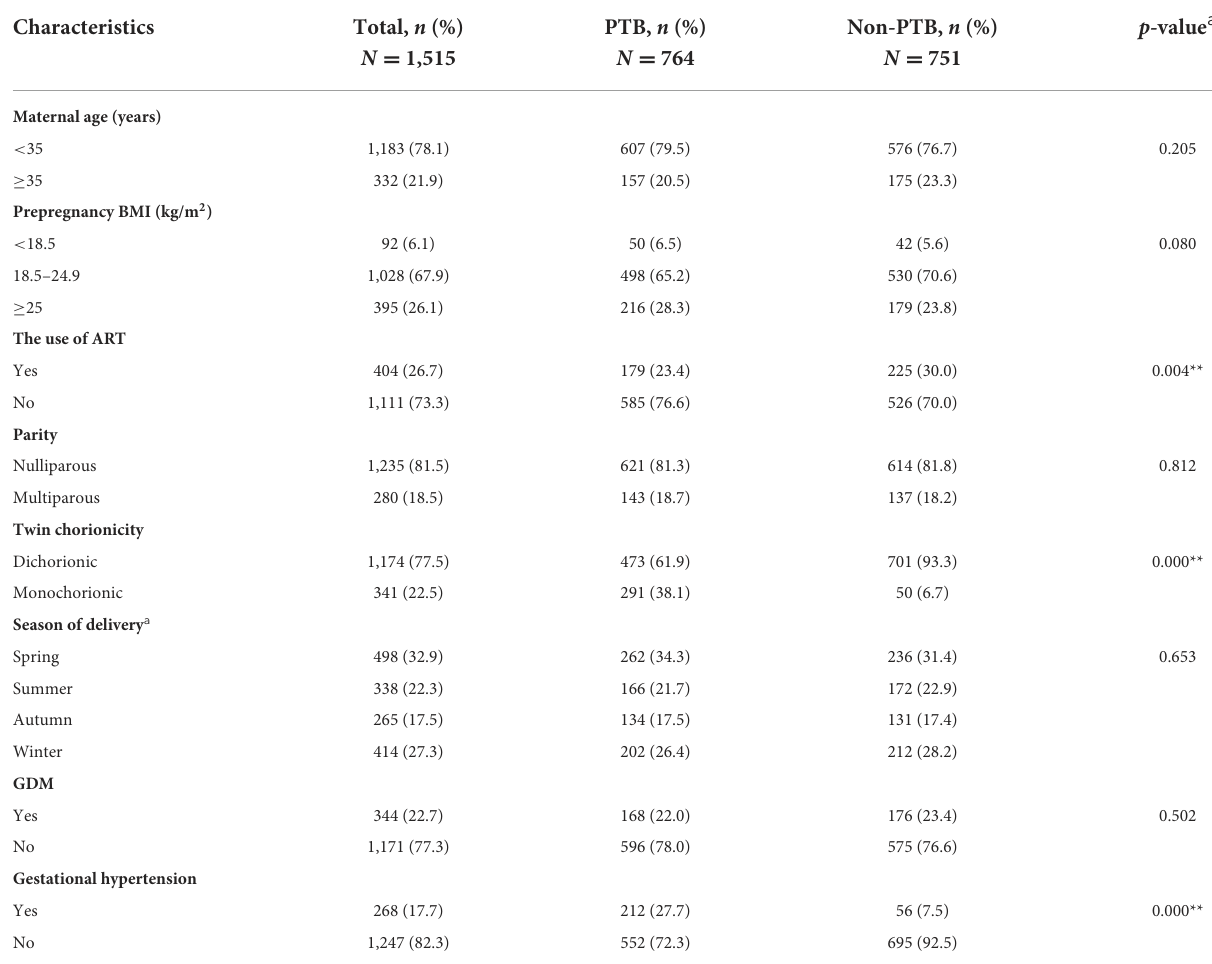
TABLE 1 General characteristics of the study